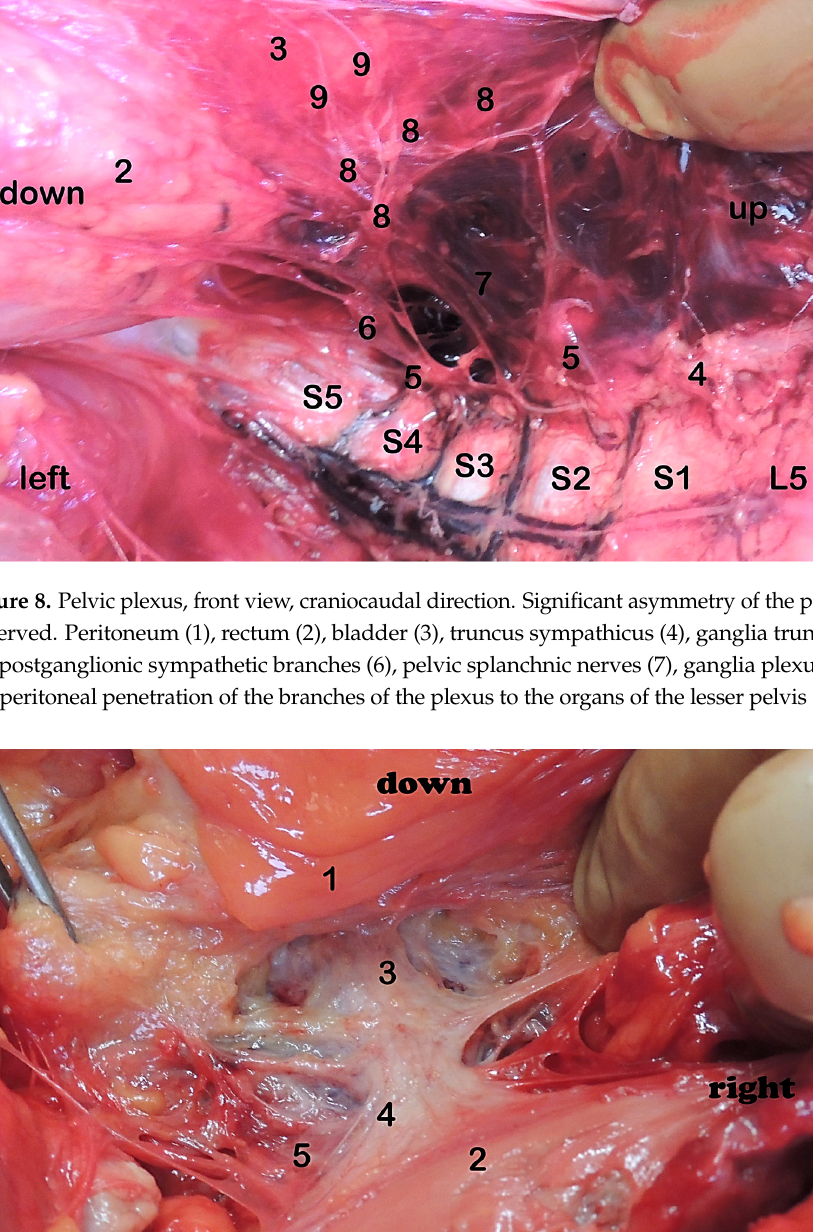
Figure 7. In the concentric type, the ganglionic masses are concentrated in a smaller number of large nodes. Connections between the plexus nerves on the periphery are less common. When the gangli- onic masses are concentrated in a smaller number of large nodes, forming the renal plexus (1), aortic plexus (2), and mesenteric plexus (3), the spermatic plexus consists of a smaller number of thin nerves arising mainly from the renal and aortic plexuses. Between the nerves at the periphery of the plexus, the connections are less common. In similar cases, the connections of the spermatic plexus with the deferential plexus (4) are also rare.